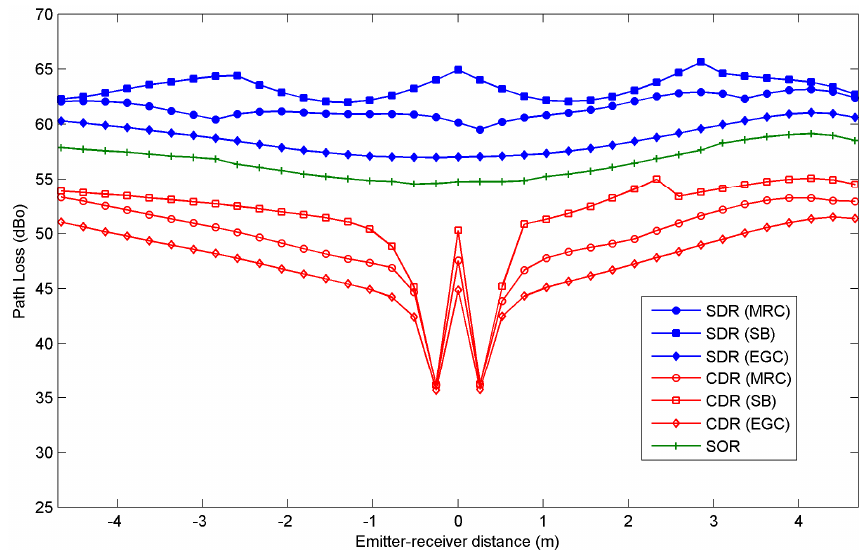
Figure 5. Delay spread for the sectored angle-diversity receiver (SDR), the conventional angle-diversity receiver (CDR) and the self-orienting receiver (SOR) as a function of the emitter-receiver distance along the diagonal from northwest (negative values) to southeast (positive values).